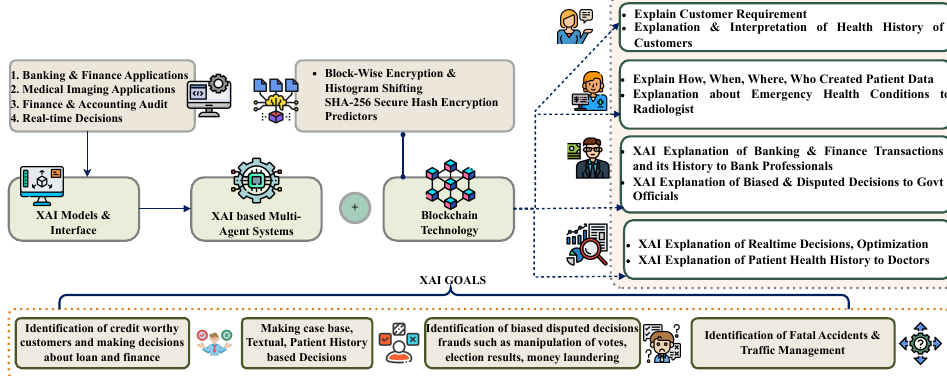
Figure 3. A Usecase of XAI with Blockchain for Smart